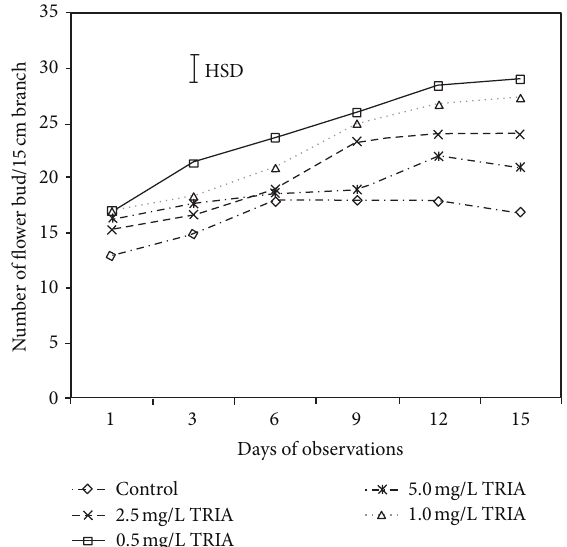
Figure 1: The effect of TRIA treatments on the flower bud formation of Bougainvillea glabra under natural